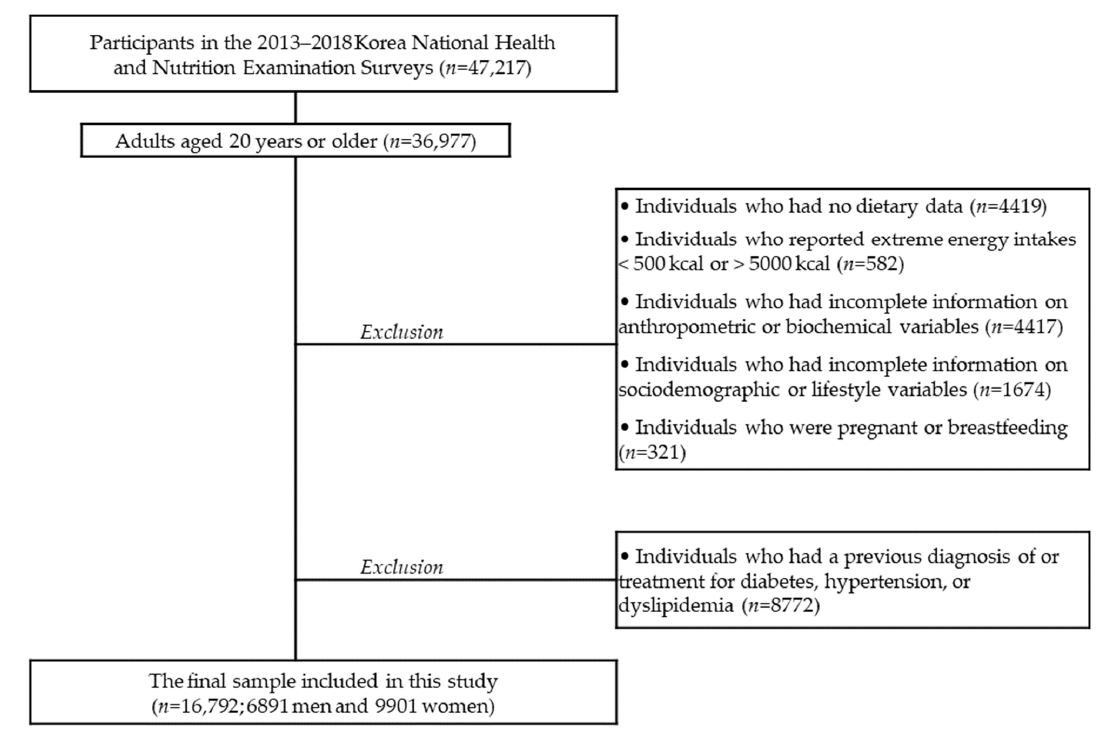
Figure 1. Selection of the study population.